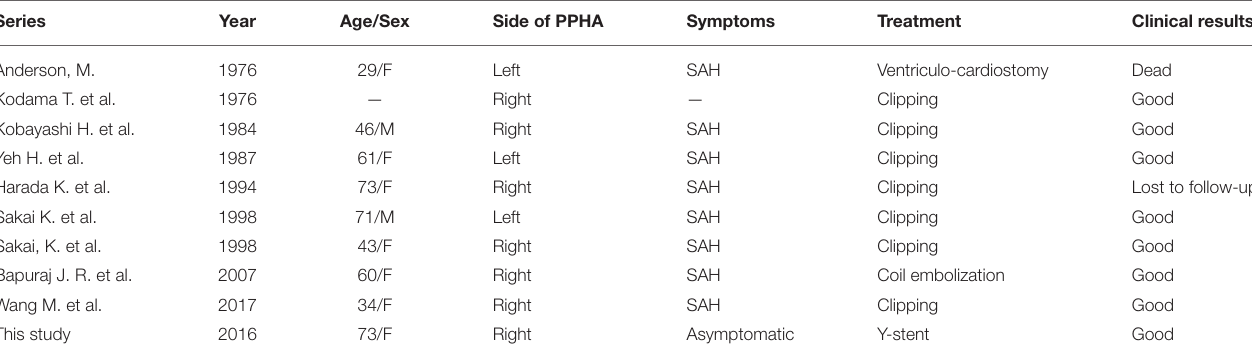
TABLE 1 | Literature review of the treatment of basilar bifurcation aneurysm accompanied by PPHA. Series Treatment Anderson,